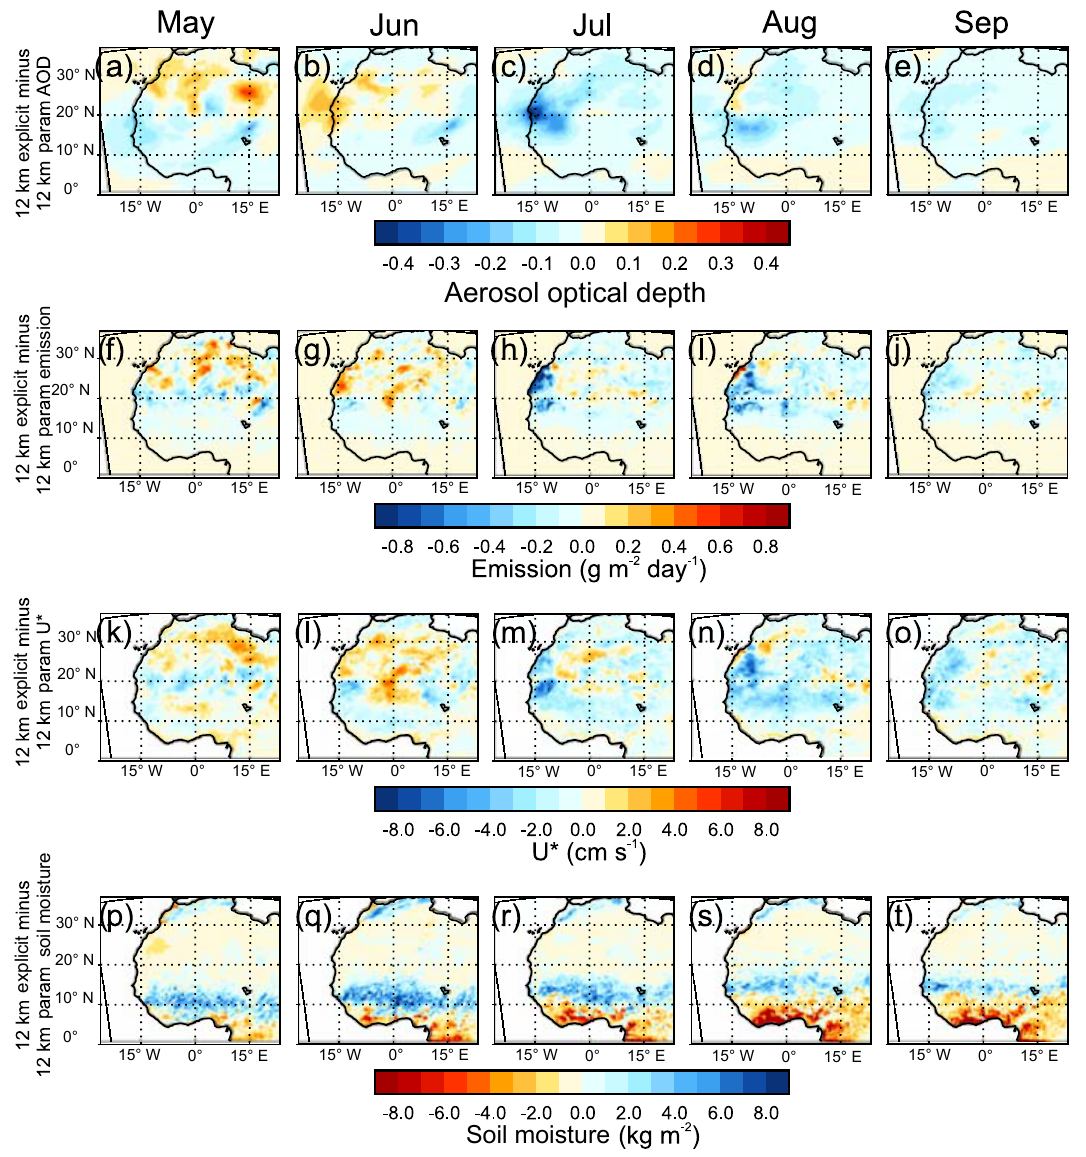
Figure 5. Monthly mean (May–September) difference maps showing (a–e) aerosol optical depth (AOD), (f–j) dust emission, (k–o) fric- tion velocity over bare soil ( U ∗ ) and (p–t) soil moisture between 12km simulation with explicit convection and 12km simulation with parameterised convection